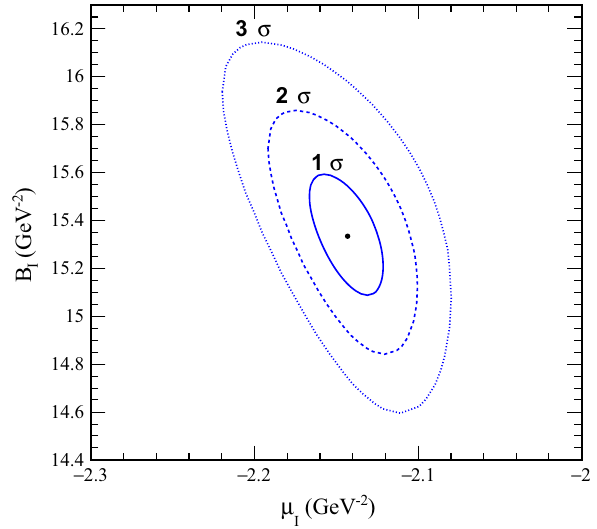
Fig. 5 Correlation map between the parameters B I and μ I for the extended T7 set (104 points) studied under Condition (I)